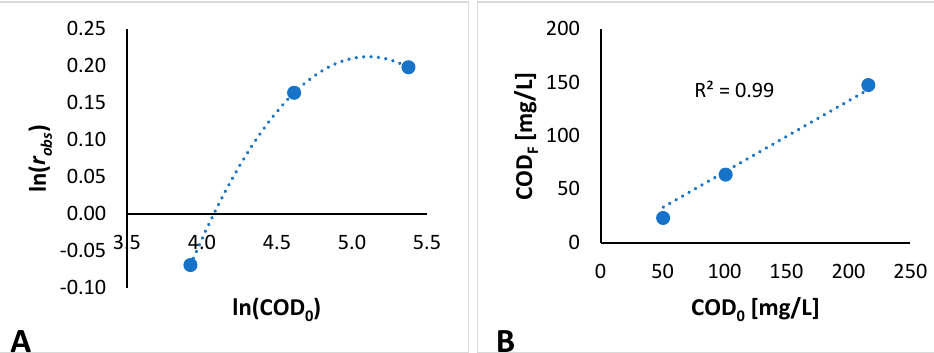
Figure 7. Effect of the initial COD value on ( A ) the observed reaction rate, r obs , and ( B ) the COD plateau value, COD F .